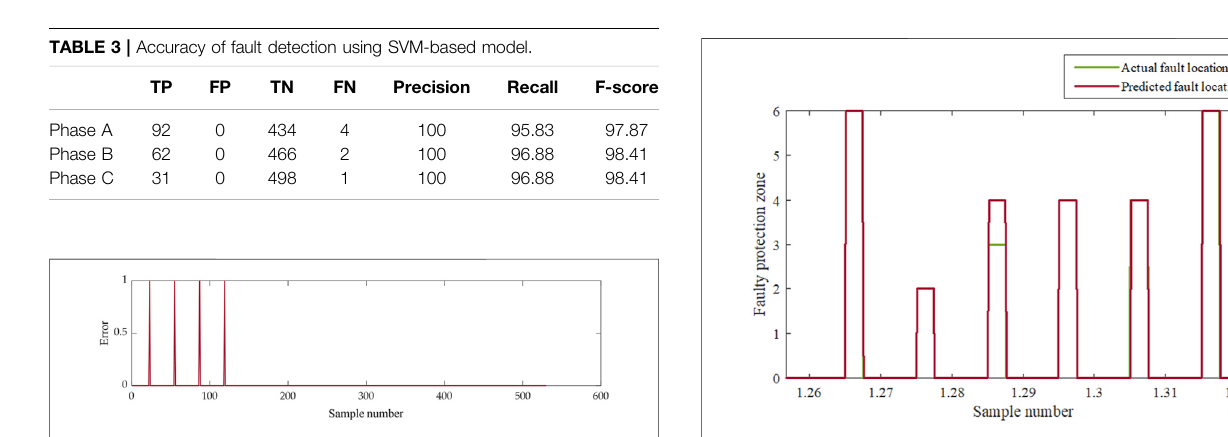
FIGURE 10 | Error in fault detection (Phase A). FIGURE 11 | Predicted fault location using LSTM model (Phase